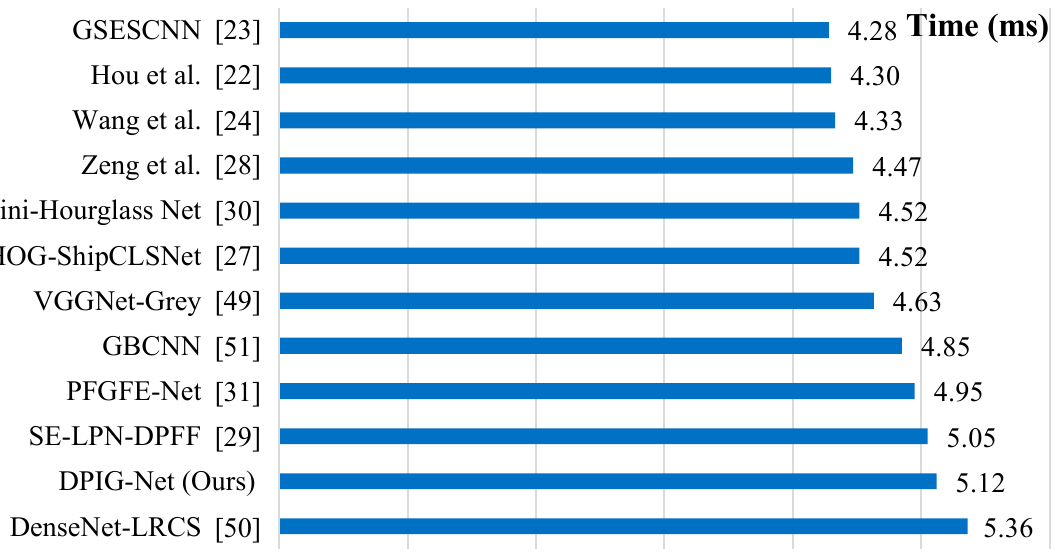
Figure 6. Classification time comparison. Time is sorted from short to long. Figure 6. Classi fi cation time comparison. Time is sorted from short to long.